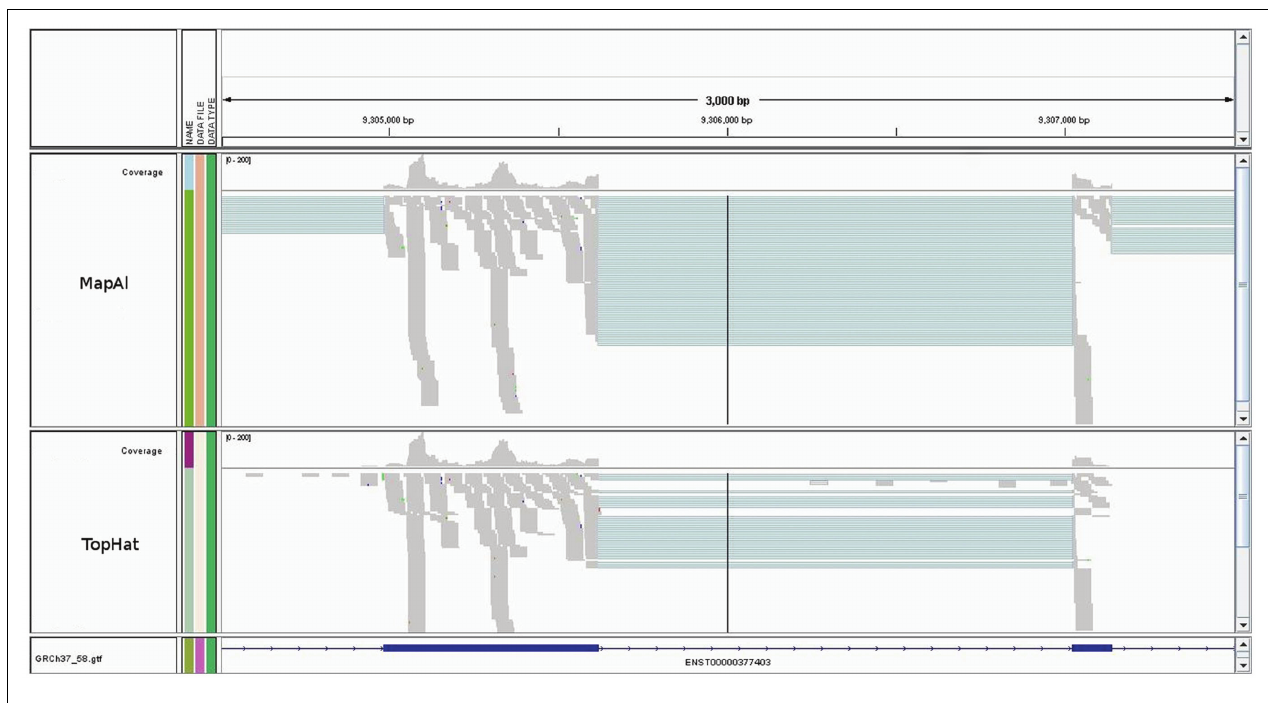
top reflects that reads entirely falling into exons are mapped identically by both MapAl (top) and TopHat (bottom).The difference is in the alignments of reads straddling splice